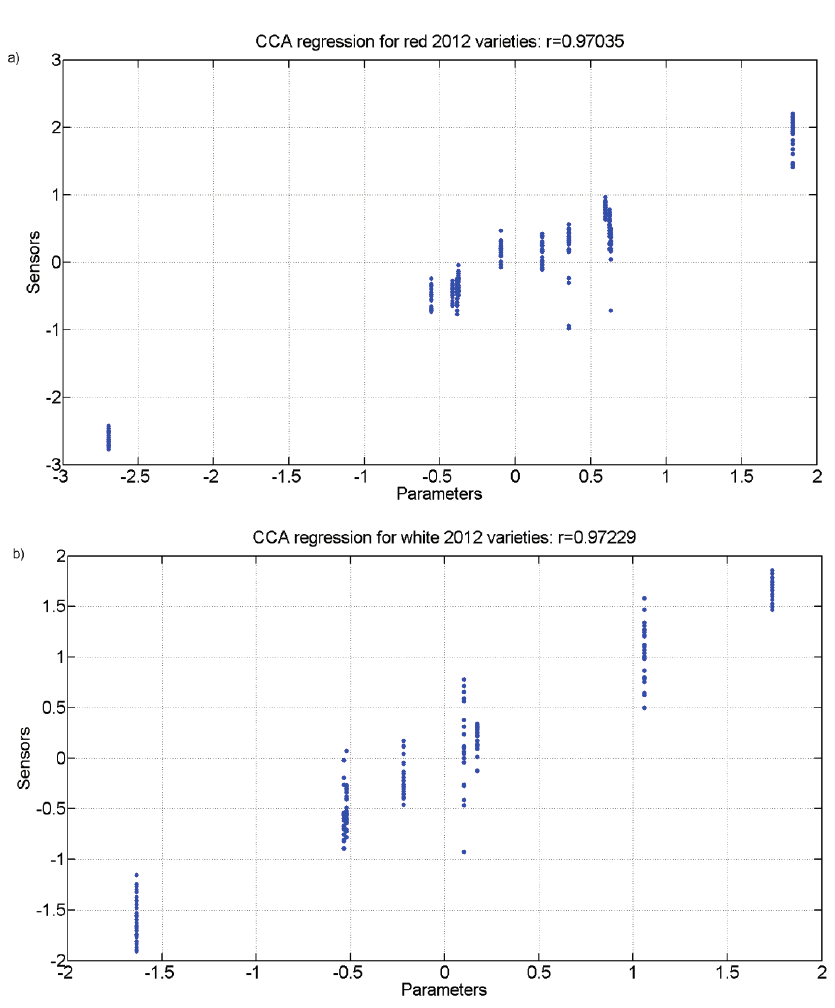
Figure 11. r values for the canonical correlation between grape must parameters and sensor responses for grape must varietiesof 2012. ( a ) Red varieties; ( b ) White varieties.